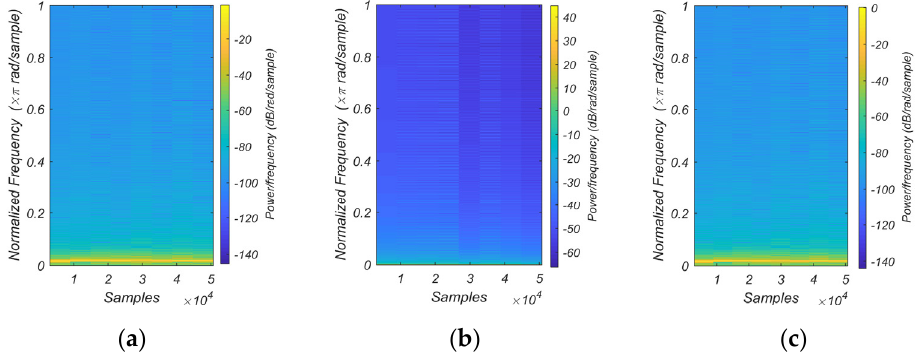
Figure 11. The spectrogram analysis: ( a ) the original information signal; ( b ) the encrypted signal; ( c ) the retrieved signal.